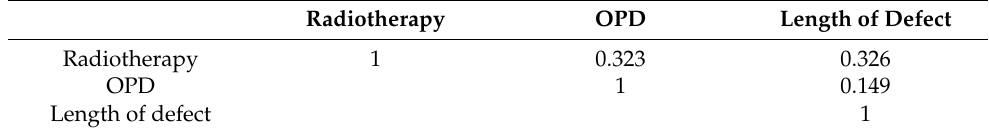
Table 7. Correlation between Radiotherapy, OPD and Length of Defect.